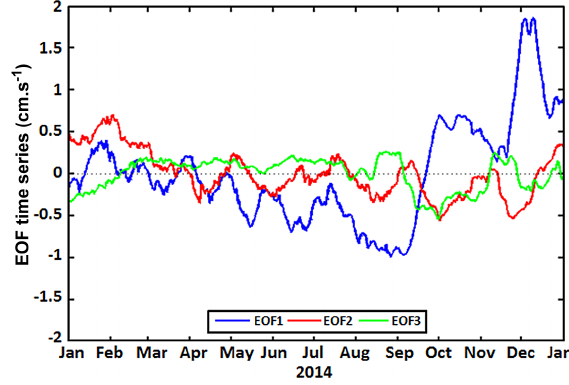
Figure 11. Time coefficients of the first (blue), second (red) and third (green) EOF modes of the hourly radar current data set evalu- ated for the entire year 2014. Time series have been filtered with a 20-day running